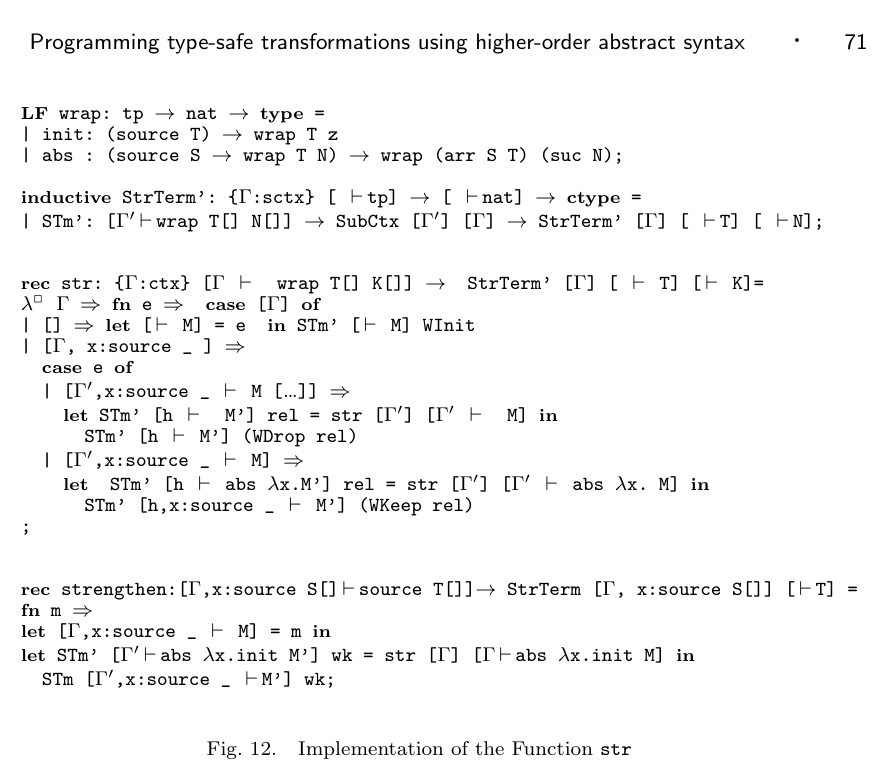
Fig. 12. Implementation of the Function